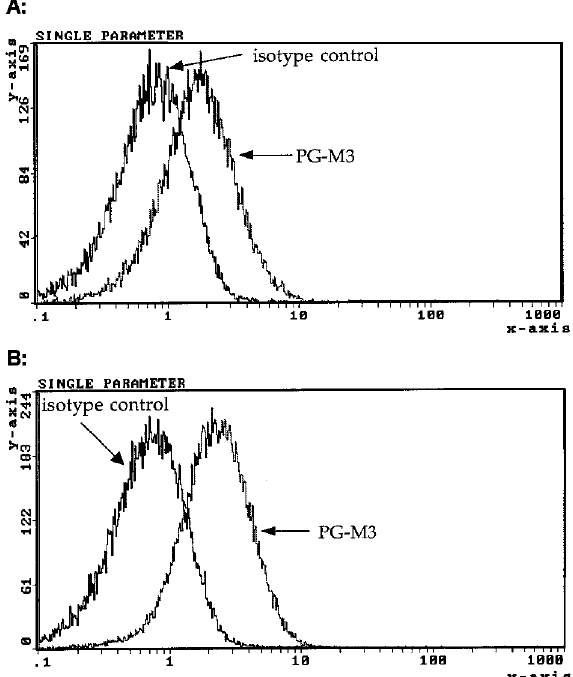
FIG. 7. Dose-response of induction of PML protein by IFN- a in U937 cells. U937 cells were incubated for 18h in the absence or presence of the indicated dose of IFN- a and PML protein expression was analysed by flow cytometry using a specific monoclonal antibody as described in Materials and Meth- ods. Given is the mean log specific fluorescence intensity as described in Materials and